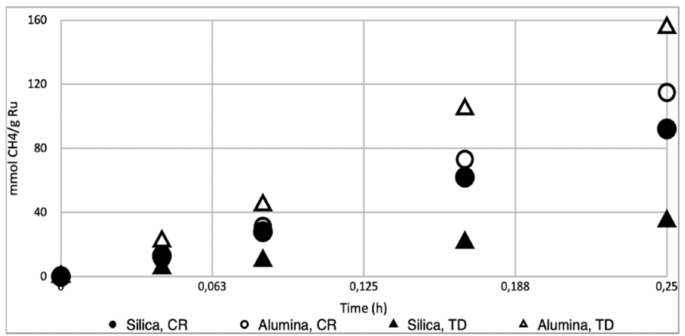
Figure 4. Conversion-time profile for the Sabatier reaction carried out in light conditions (6.66 suns) with Ru/Al 2 O 3 catalysts prepared using Ru 3 (CO) 12 (TD, 3.6% w / w Ru, ∆ ) [33] and RuCl 3 (CR, 3.89% w / w , ), and their SiO 2 supported counterparts Ru/SiO2–TD (3.49% w / w , (cid:78) ) and Ru/SiO 2 - (cid:35) CR (3.88% w / w , • ). Reaction conditions for all experiments: reaction mixture of H 2 /CO 2 /N 2 (4.5:1:1) at 3.5 ± 0.2 bar pressure, 200 mg of Ru/Al 2 O 3 or Ru/SiO 2 catalyst, catalyst bed temperature of approximately 220 ◦